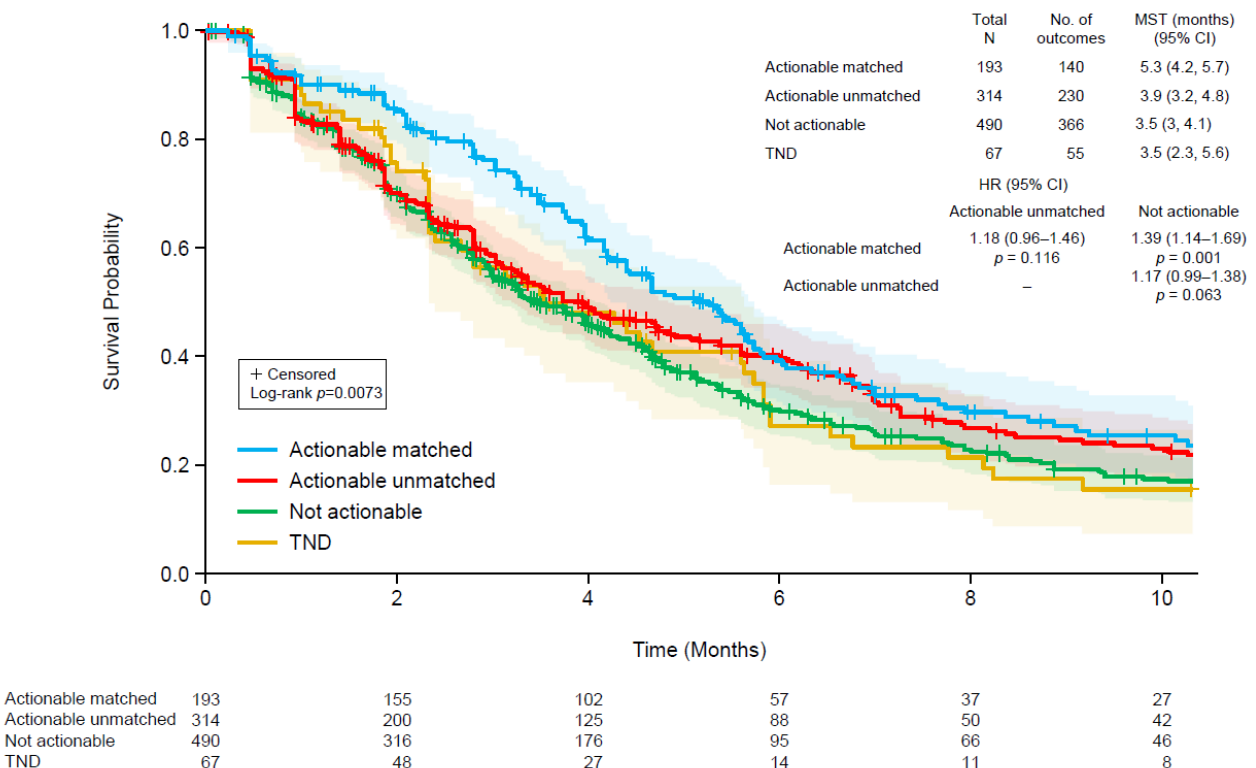
Figure 2. Kaplan–Meier plots of time to discontinuation of therapy following ctDNA testing using a Guardant360 assay in four groups: (1) patients with a clinically actionable genomic profile who received matched therapy (blue), (2) patients with a clinically actionable genomic profile who did not receive a matched therapy (red), (3) patients without a clinically actionable genomic profile (green), and (4) patients in whom ctDNA was not detected (brown). The shaded regions indicate 95% confidence intervals. CI, confidence interval; HR, hazard ratio; MST, median survival time.